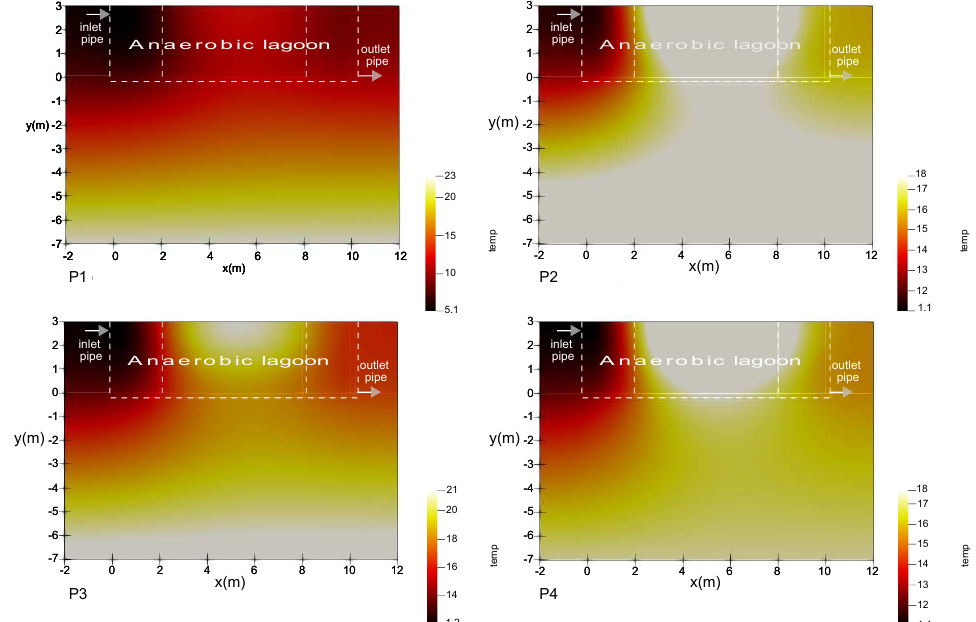
Figure 3. Temperature distribution under four different scenarios, according to the characteristic parameter exposed in Table